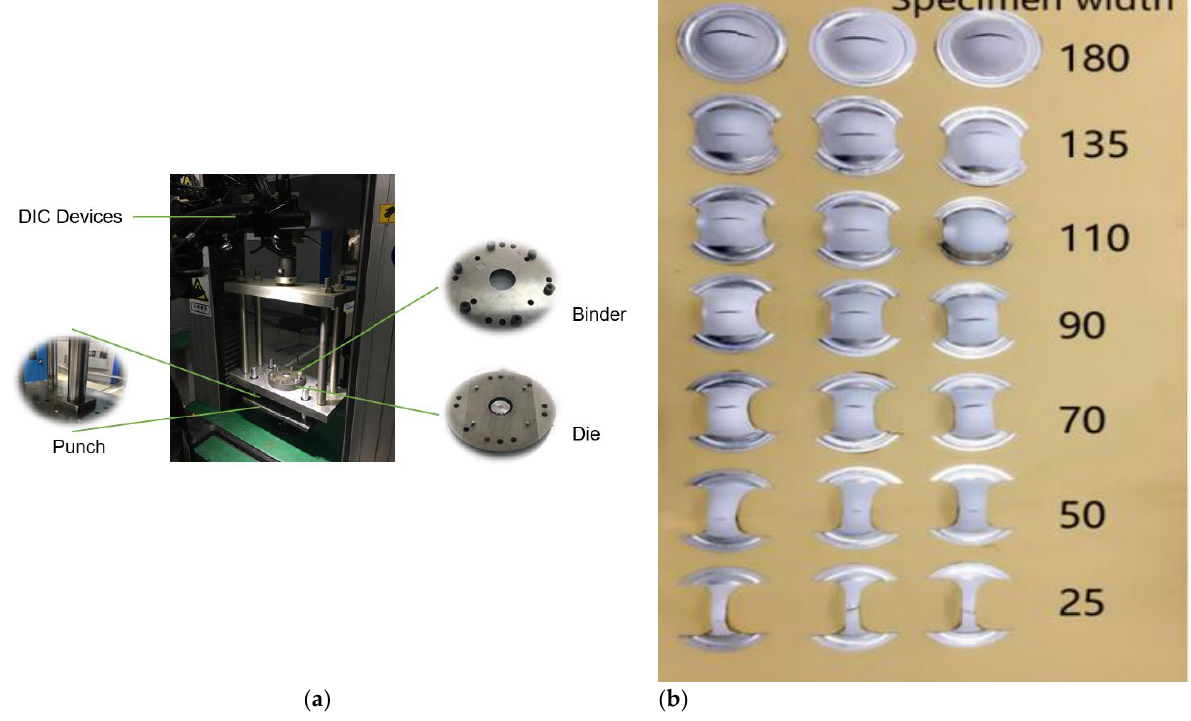
Figure 2. Experimental setup of the mini-Nakazima forming limit test and tested specimen (unit: mm): ( a ) experimental setup; ( b ) tested specimens. (unit: mm): ( a ) experimental setup; ( b ) tested